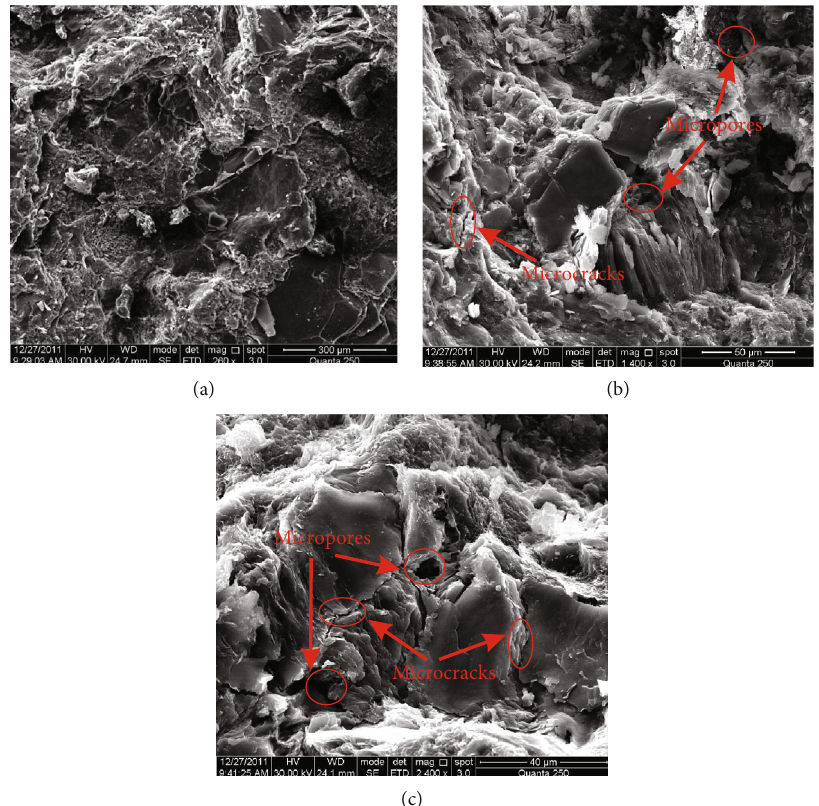
Figure 1: Microstructures of sandstones obtained by SEM. (a) 260x; (b) 1400x; (c) 2400x.